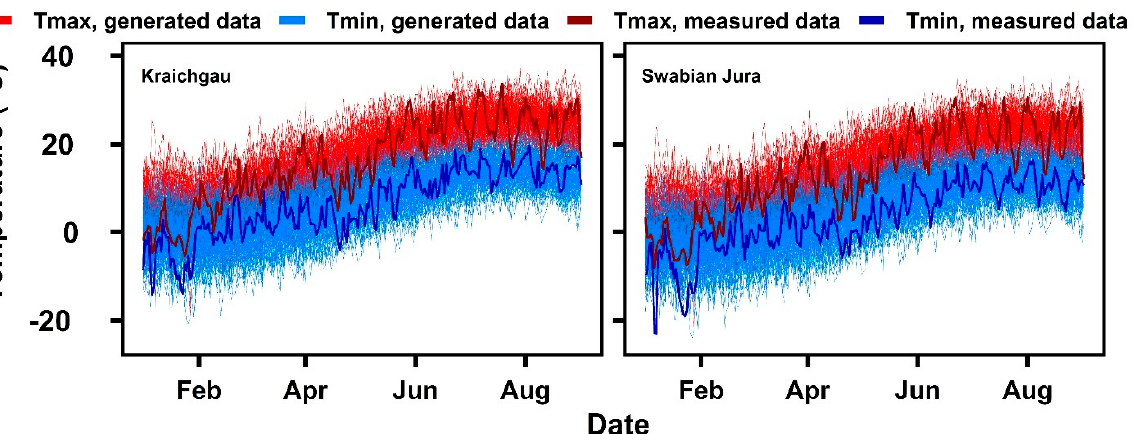
Table 2. Information on the satellite images used for data assimilation in the study. Cloud-free images from mid-March to the end of June (wheat anthesis) were selected. Year Kraichgau